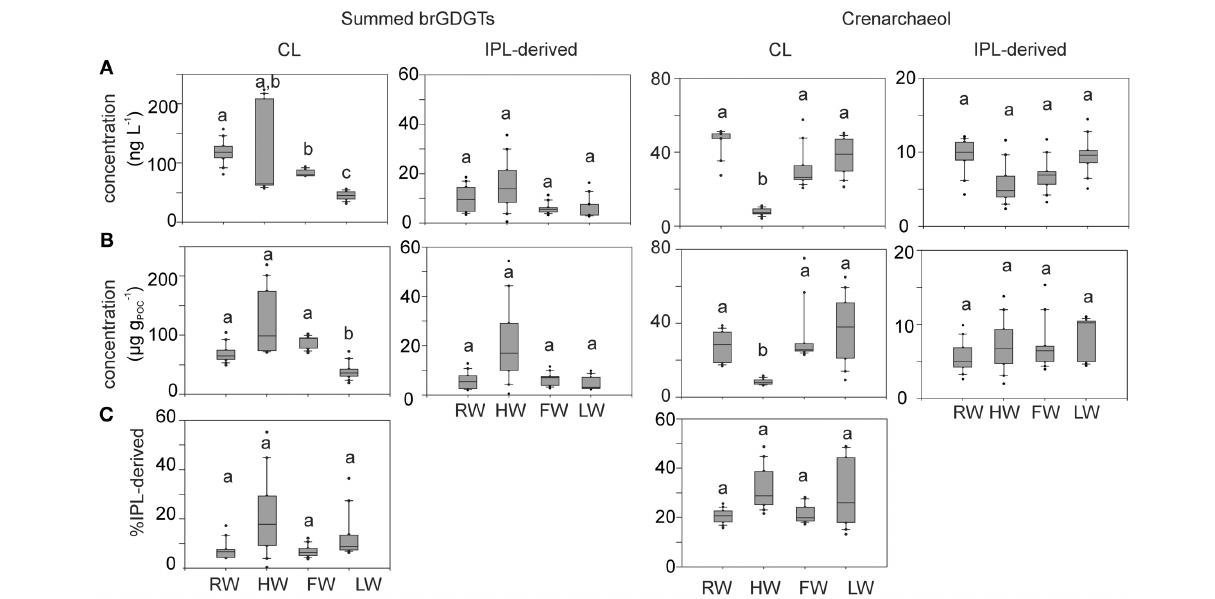
Amazon main stem (Solimões and stations Amazon 1–4) at four different seasons. Letters indicate statistically significant groups of data ( p < 0 .